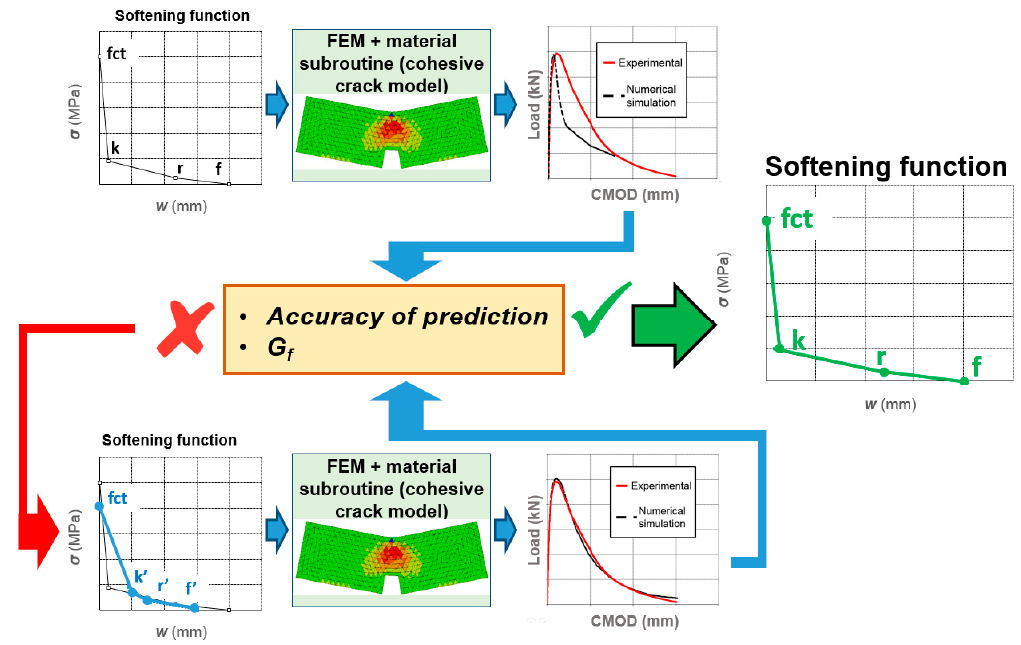
Figure 4. The iterative procedure used to obtain the softening functions.